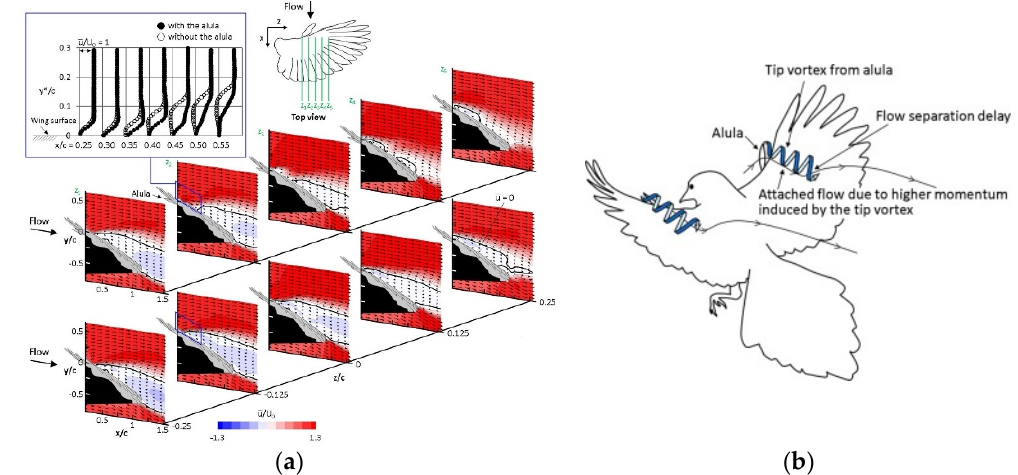
Figure 5. ( a ) Contours of the time-averaged streamwise velocity at five spanwise locations on the wing (upper panel: with the alula; lower panel: without the alula). ( b ) Artist’s impression of the effect of the alula-tip vortex on flow separation [6].